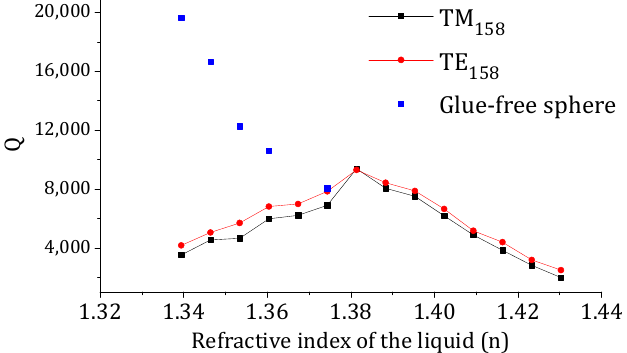
Figure 3. The effective Q-factors of the TM 158 and TE 158 modes as a function of the refractive index (RI) of the probing liquid. The blue dots represent the Q-factors as a function of the RI of the surrounding liquid for a free-standing 20 µm sphere taken from the same batch as the sphere partially covered in glue.